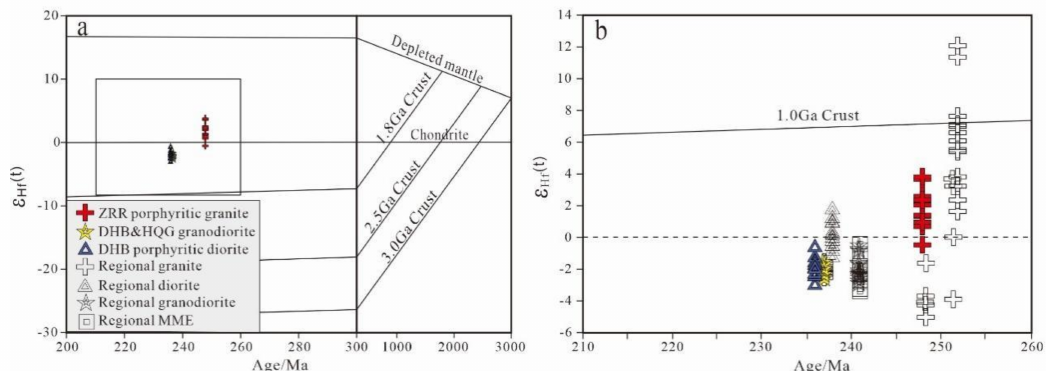
Figure 8. ( a ) Diagram of the zircon ε Hf (t) versus ages for the granotoids in the Ela Mountain area (this study). ( b ) Plot of the zircon ε Hf (t) versus ages for the intermediate-acid intrusive rocks in the Ela Mountain area (the sources of the published data are the same as those in Figure